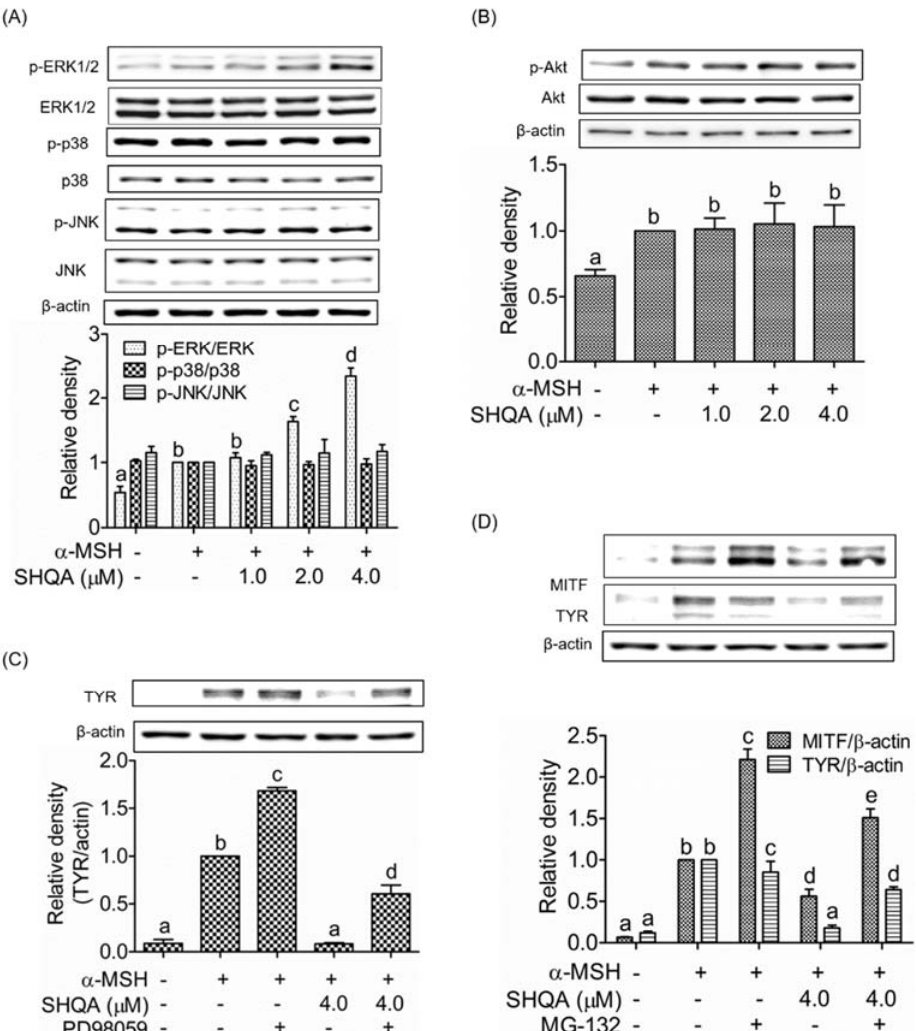
Figure 5. Effect of SHQA on melanogenic upstream signaling pathways in B16F10 cells. After pre-treatment of SHQA for 1 h, cells were treated with α -MSH (1.0 µ M) for 1 h with or without SHQA. Western blotting was performed for ( A ) MAPKs and ( B ) AKT. ( C ) After pre-treatment of SHQA for 1 h with or without PD98059 (15.0 µ M), cells were treated with α -MSH for 48 h. Western blotting was performed to detect tyrosinase. ( D ) After pre-treatment of SHQA for 1 h with or without MG-132 (70 nM), cells were treated with α -MSH for 48 h. Western blotting was performed for MITF and tyrosinase. The band images were measured by densitometry and shown as bar graphs. Data are expressed as the mean ± standard deviation (SD) ( n = 3). Different superscripts represent statistical significance at p < 0.05.